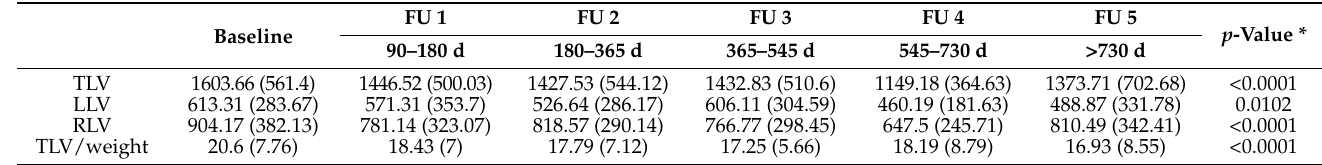
Figure 1. Total liver volume (mL) over time (in days). Repeated measurements are connected by lines for each patient. Discretized assessment periods are marked by dashed vertical lines. Table 3. Baseline and follow-up liver volume regarding TIPS insertion (mean (SD)).